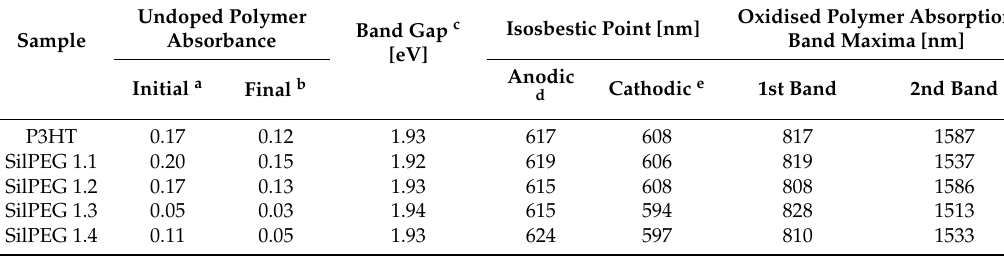
Table 4. Key spectral parameters for the investigated P3HT and copolymer